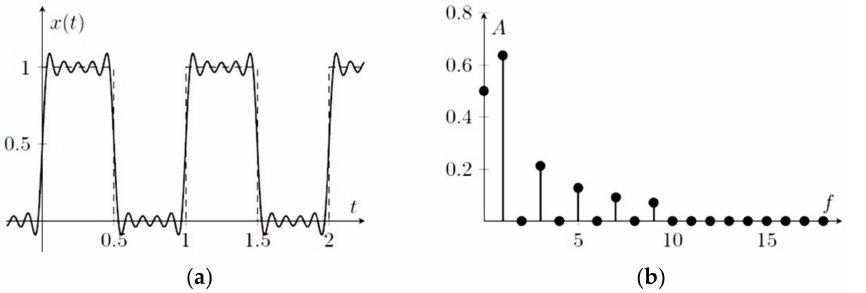
Figure 1. Distorted square wave representation: ( a ) time-domain; ( b ) frequency-domain